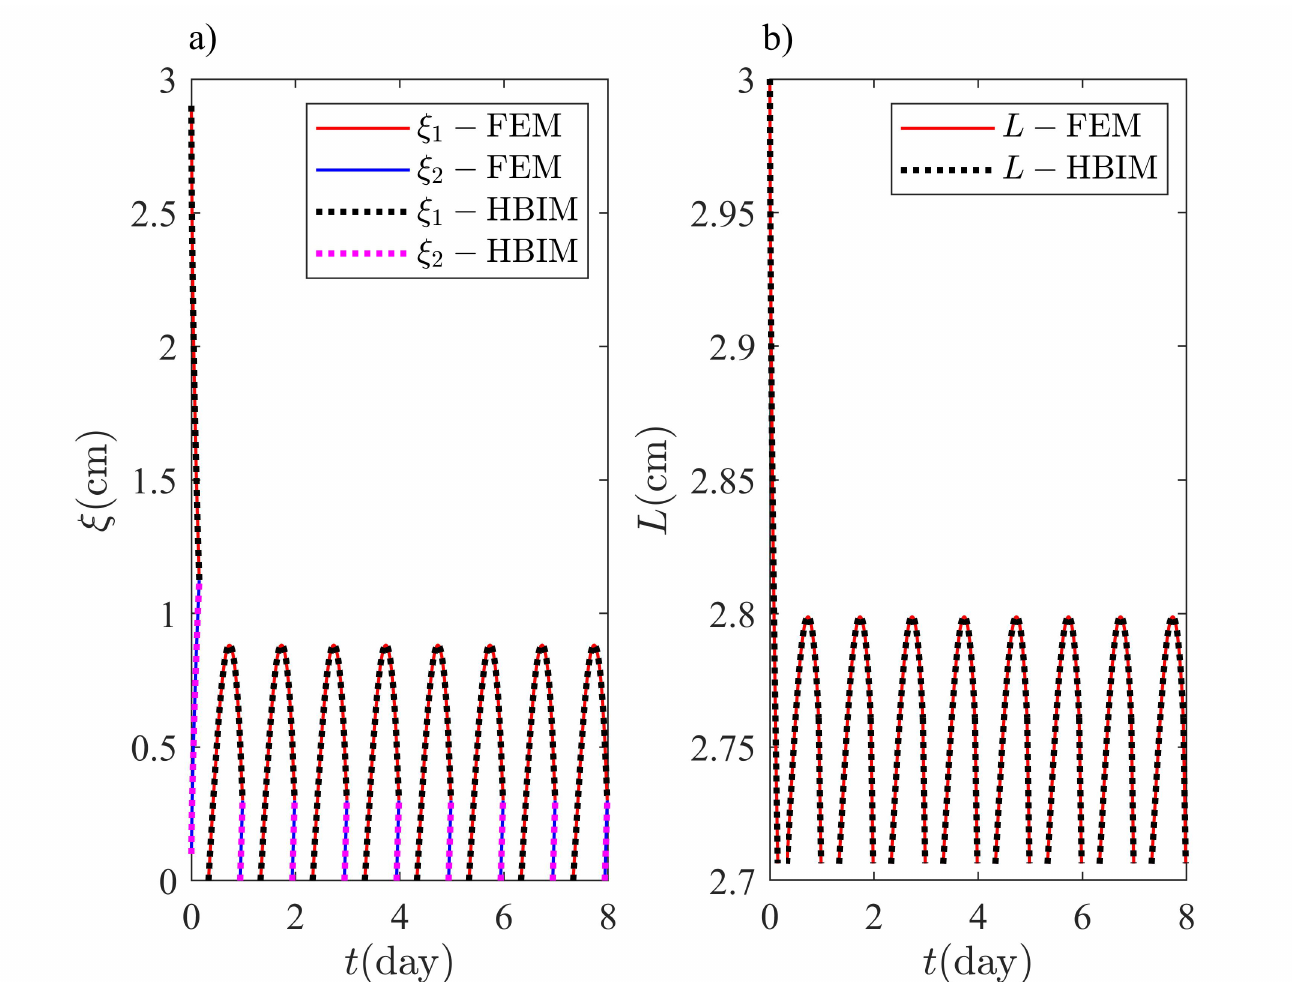
Figure 10. Time evolution of: ( a ) ξ 1 ( t ) , ξ 2 ( t ) , and ( b ) L ( t ) , according to the HBIM and FEM solutions to Equations (4), (13), (16), and (18). Solid and dotted lines represent the FEM and HBIM solutions,